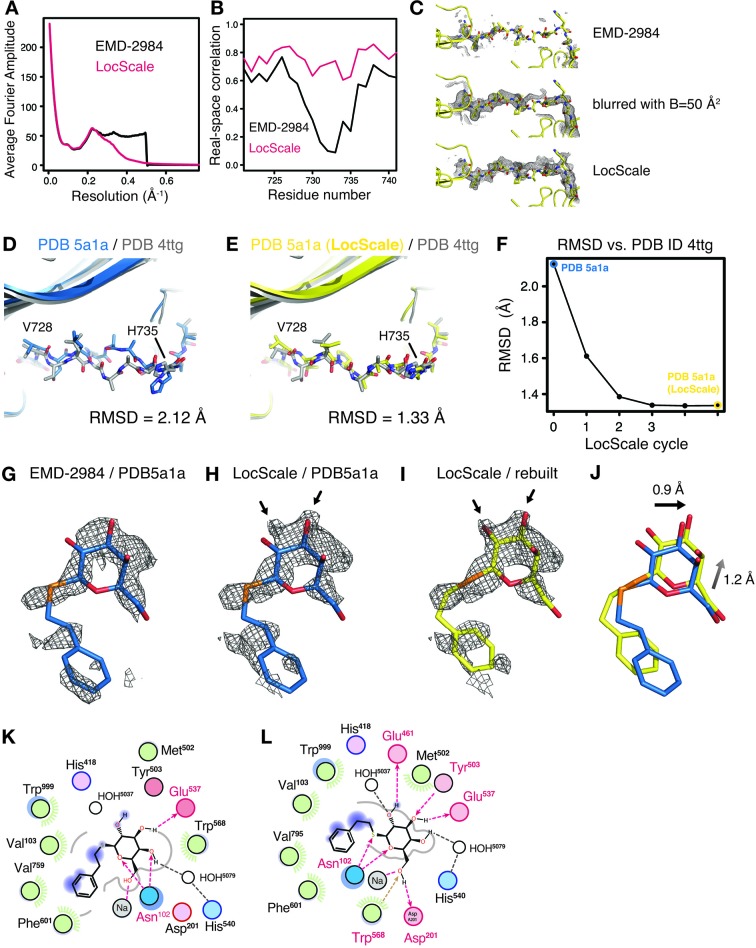
Comparison of β-galactosidase radial amplitude profiles and iterative refinement of coordinates from the V728–H735 loop region.(A) Radial amplitude spectrum of LocScale β-galactosidase map. In comparison with the deposited map obtained by uniform B-factor sharpening, the LocScale procedure results in a smooth falloff to high-resolution amplitudes. (B) Residue-based real-space correlation improves in the V728–H735 loop region for the conformation built using the LocScale map. (C) Comparison of density for the V728–H735 region in EMD-2984 (top), EMD-2984 after blurring with a B-factor of 50 Å2 and the LocScale map for EMD-2984 (bottom). Maps are contoured at 3σ and displayed with a carve radius of 2.0 Å. (D) Comparison of the V728–H735 stretch of PDB ID 5a1a (blue) with the 1.6 Å crystal structure of E.coli β-galactosidase PDB ID 4ttg (silver). The RMSD states the root mean square deviation between PDB IDs 5a1a and 4ttg computed across all atoms in the sequence V728–H735. (E) Same view as (C) comparing the model after rebuilding and iterative refinement using the LocScale procedure (yellow). (F) Plot of the model differences in RMSD (Å) illustrated in (C) and (D) as a function of alternating LocScale and refinement cycle. (G–J) Density for the PETG ligand bound in the active site as observed in EMD-2984 (G) and LocScale map (H) superposed on the PETG conformation from PDB ID 5fja shown in stick representation. Enhanced density features of the hydroxyl substituents in the hexapyranosyl ring become visible in the LocScale map (arrows) and require re-arrangement of the ligand orientation in the active site (I and J). (K and L) FLEV ligand environment computed from PDB ID (5fja) and the model after refinement against the LocScale map. Re-orientation of the ligand based on the LocScale map increases hydrogen-bond interactions in the active site. Note also the significantly decreased substitution contour (gray line) for the LocScale conformation, indicating tighter apposition in the active site.